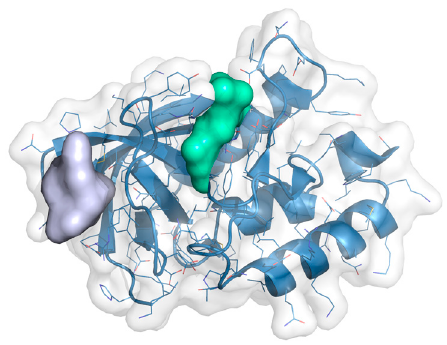
Figure 7. PDB 6ok9 with the pocket detected by 3decision represented by the purple surface and the correct pocket represented by the green surface.